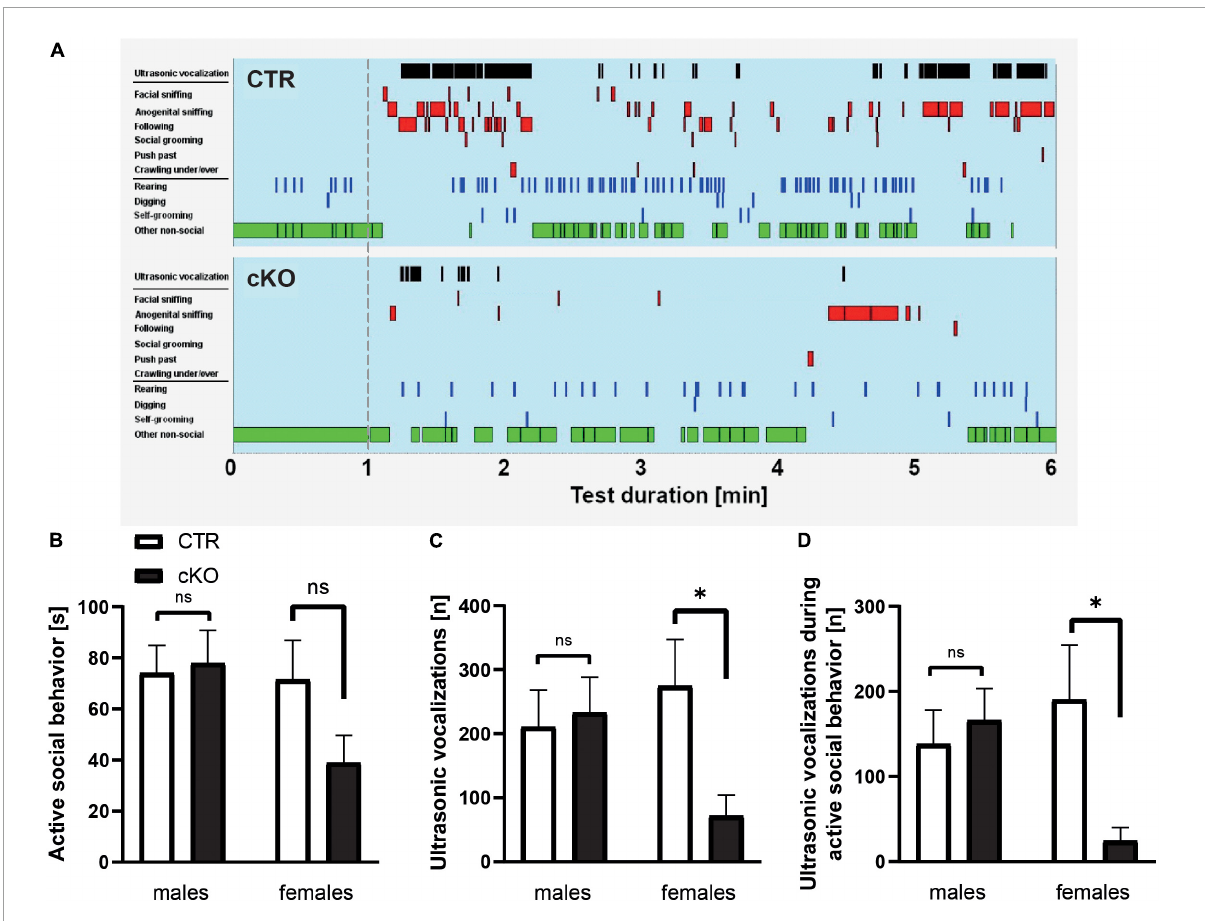
FIGURE3 Normal reciprocal social interaction, but reduced ultrasonic vocalizations in juvenile cKO mice. (A) Representative ethograms of female CTR and KO pairs during a 5-min test phase (1–6, min right to the dashed line) upon 1 min of habituation (left to the dashed line). Depicted are ultrasonic vocalizations (black bars in row 1), six different social activities (i.e., facial sniffing, anogenital sniffing, following, social grooming, push past, and crawling under/over, red bars in rows 2–7), three different non-social activities (i.e., rearing, digging, and self-grooming, blue bars in rows 8–10), and other non-social activities (green bars in row 11). (B) Time spent in active social behavior (s), male CTR: 74.14 ± 10.7, cKO: 78.0 ± 12.8, F 1 , 19 = 0.05, p = 0.825, n = 20 pairs; female CTR: 71.5 ± 15.5, cKO: 39.0 ± 10.7, F 1 , 15 = 2.630, p = 0.127, n = 16 pairs. (C) Number of ultrasonic vocalizations (n), male CTR: 210.9 ± 57.6, cKO: 233.1 ± 55.5, F 1 , 19 = 0.076, p = 0.786; female CTR: 274.7 ± 72.9, cKO: 71.4 ± 32.7, F 1 , 15 = 5.328, p < 0.05. (D) Number of ultrasonic vocalizations during active social behavior (n), male CTR: 138.2 ± 40.0, cKO: 166.0 ± 37.6, F 1 , 19 = 0.254, p = 0.620; female CTR: 190.4 ± 63.9, cKO: 24.3 ± 15.6, F 1 , 15 = 5.004, p < 0.05. ns: p = 0.05, * p <